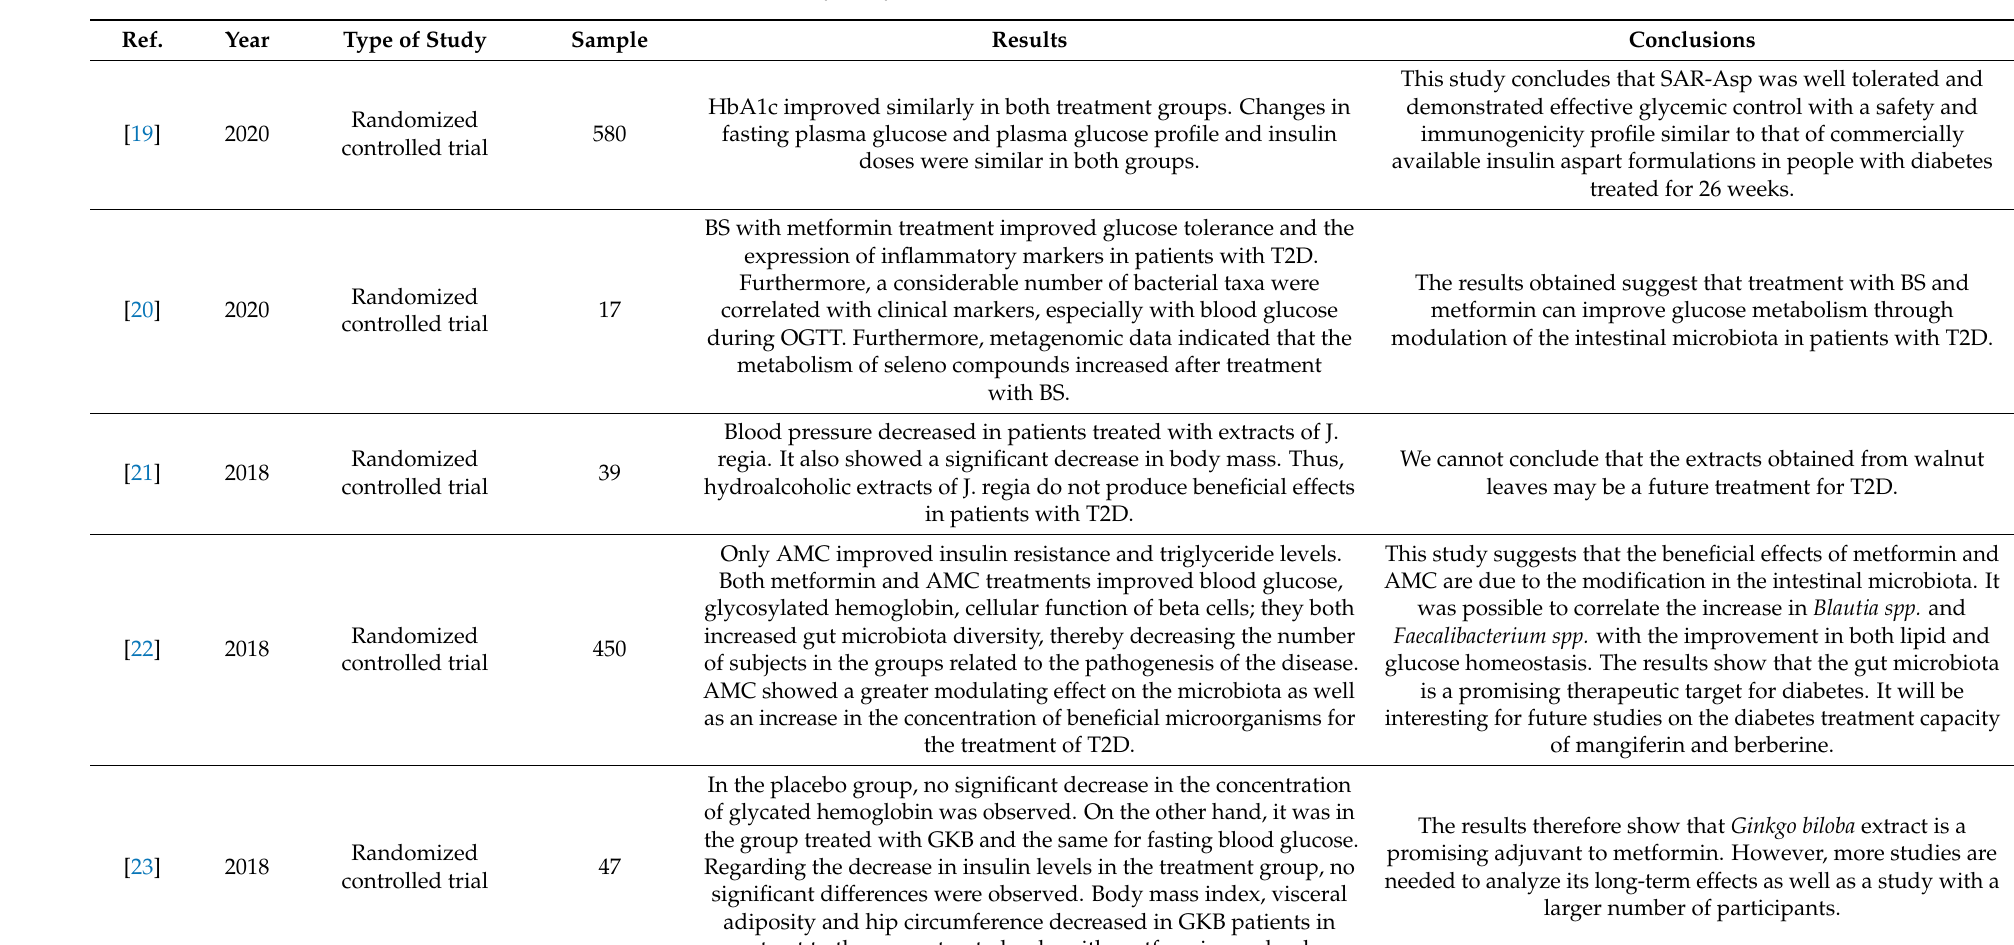
Table 1. Main characteristics of each study